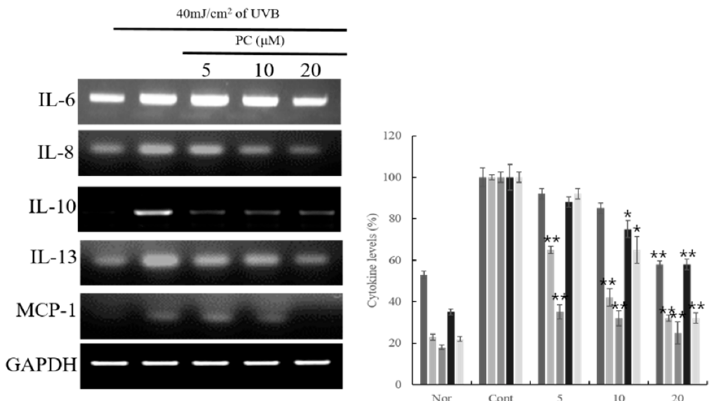
Figure 2. E ff ect of PC ( 1 ) treatment on cytokine mRNA expression in HaCaT cells. HaCaT cells were treated with di ff erent concentrations of PC ( 1 ) (5, 10, 20 µ M) for 1 h. The cells were further stimulated with 40 mJ / cm 2 UVB. After 6 h, the cells were harvested, and relative mRNA levels were determined. Histograms show the densitometric data for TARC and MDC mRNA normalized to GAPDH. Each value represents the mean ± SD of three individual experiments. Nor: Non-treated cell group (0 h), Cont: 40 mJ / cm 2 UVB treatment cell group. Data are expressed as the means ± S.D., n = 3. * p < 0.001 and ** p < 0.0001 compared to the control